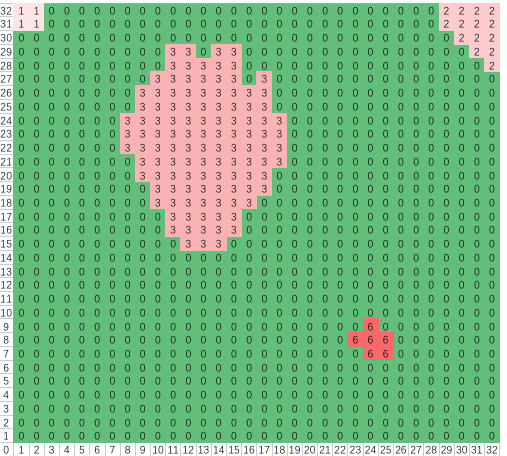
Figure 11. Adjacent blocks are merged after the second boundary scan.